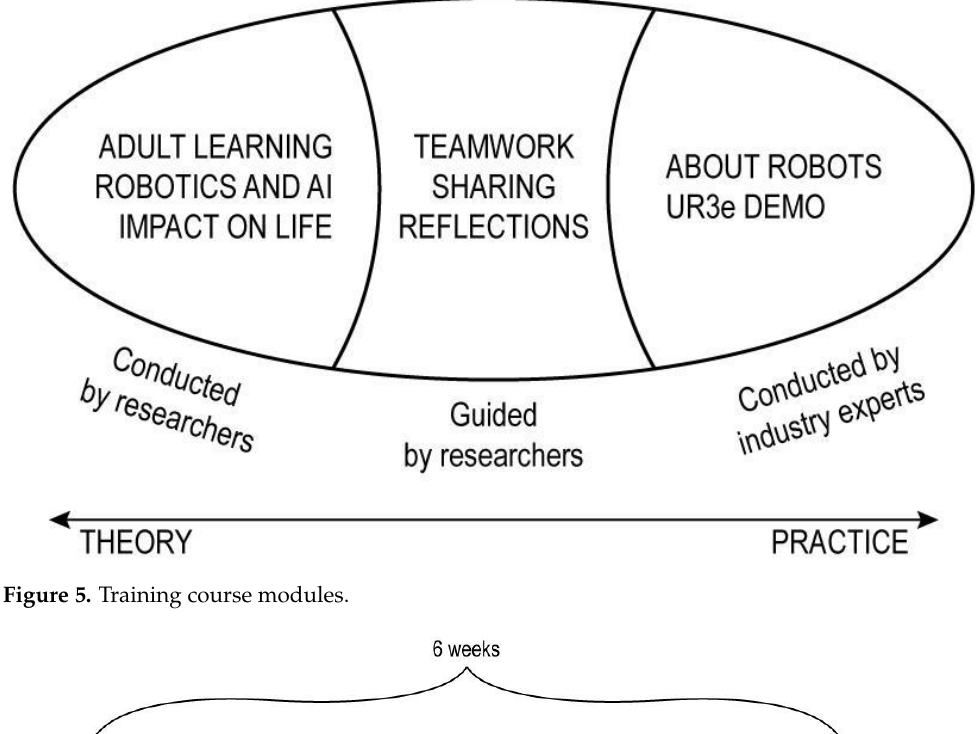
Figure 5. Training course modules.